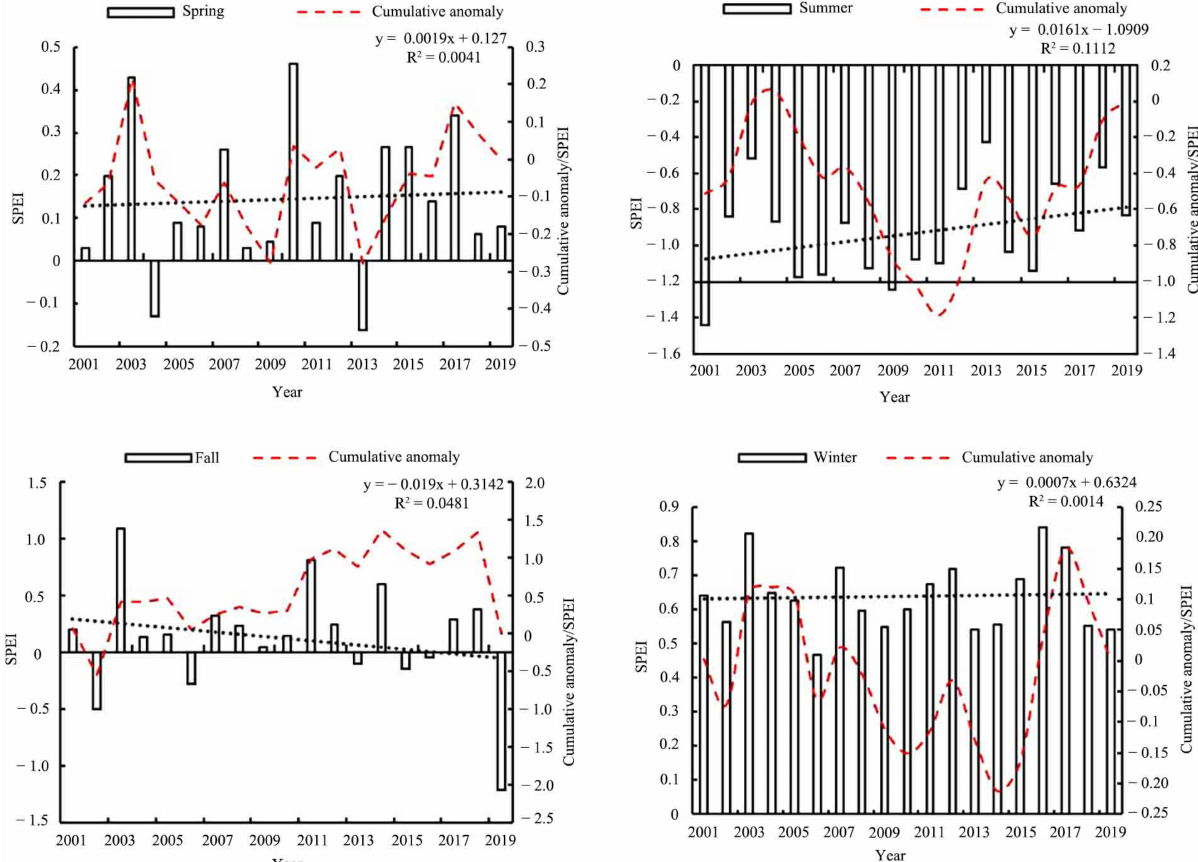
Figure 2. Long-term dynamic characteristics of seasonal standardized precipitation evapotranspira- tion index (SPEI) in the Loess